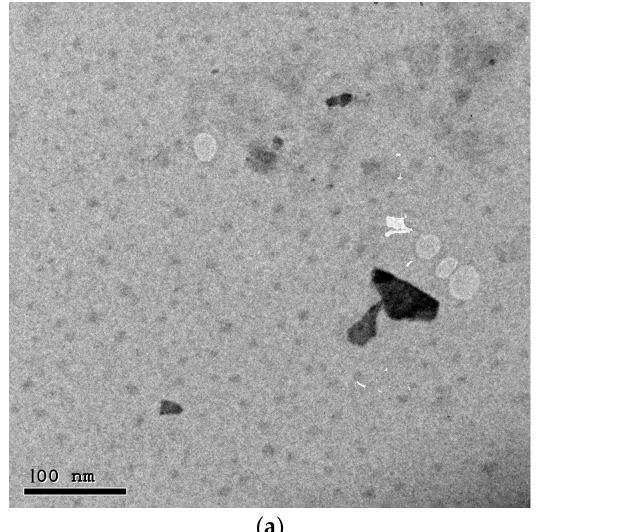
Figure 4. TEM images of ( a ) Bi 2 O 3 NPs and ( b ) WO3 NPs.